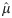
Years since divorce across maternal (n = 2,463) and paternal (n = 2,378) educational qualifications.Pairwise comparisons of years since divorce across maternal (A) and paternal (B) educational qualifications. The plots comprise a mix of a violin plot (displaying the shape of the variable distribution) and a box plot (where the box is split by the median and bounded by the first and third quartiles of the distribution) along with the jittered raw datapoints. The red dot signifies mean values, also reported in text as μ^ with accompanying 95% confidence intervals (CI95%). Only significant pairwise comparisons are shown with accompanying p-values.